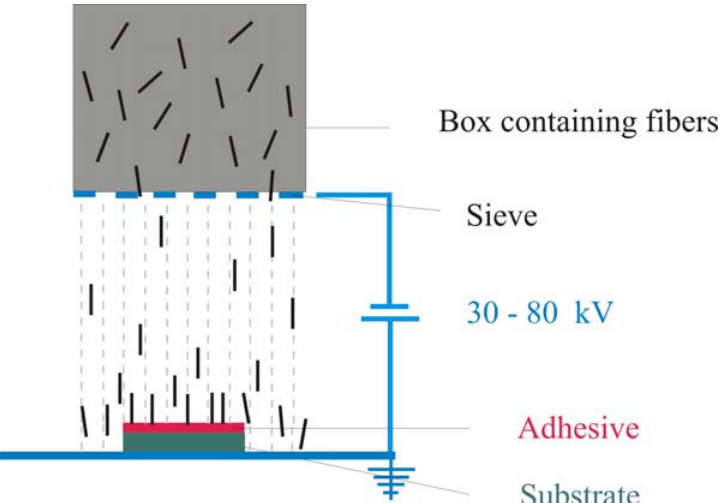
Figure 1. Schematic representation of the flocking